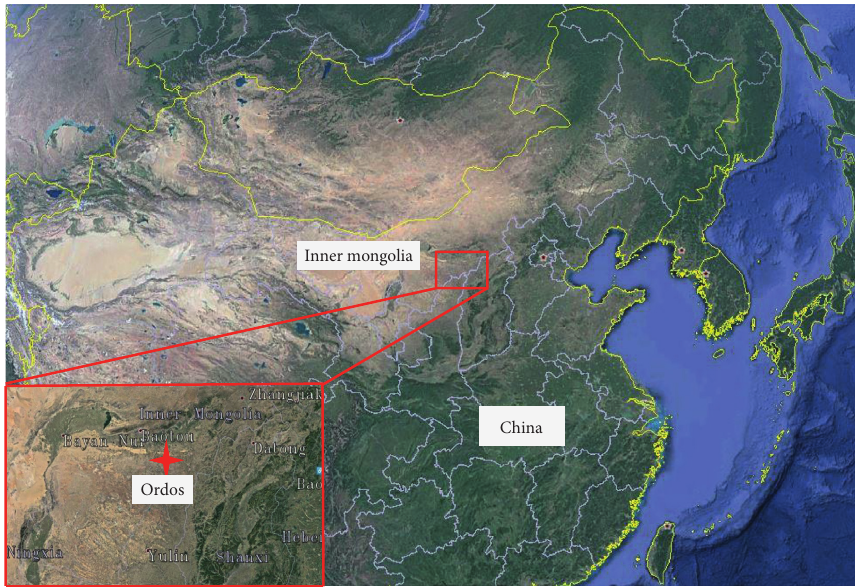
Figure 1: Location of Buliangou